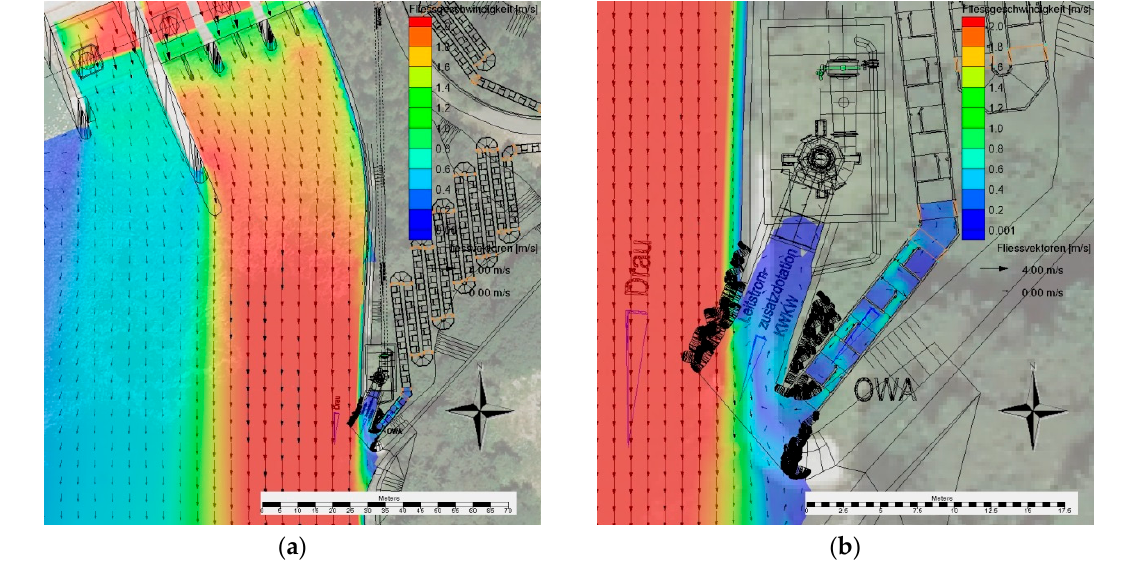
Figure 6. Alternative 1, result overview ( a ) and detail at entrance ( b ) of the 2D model. Q Drava = 485 m 3 / s, Q fish pass = 0.38 m 3 / s; competing flow <0.1%.